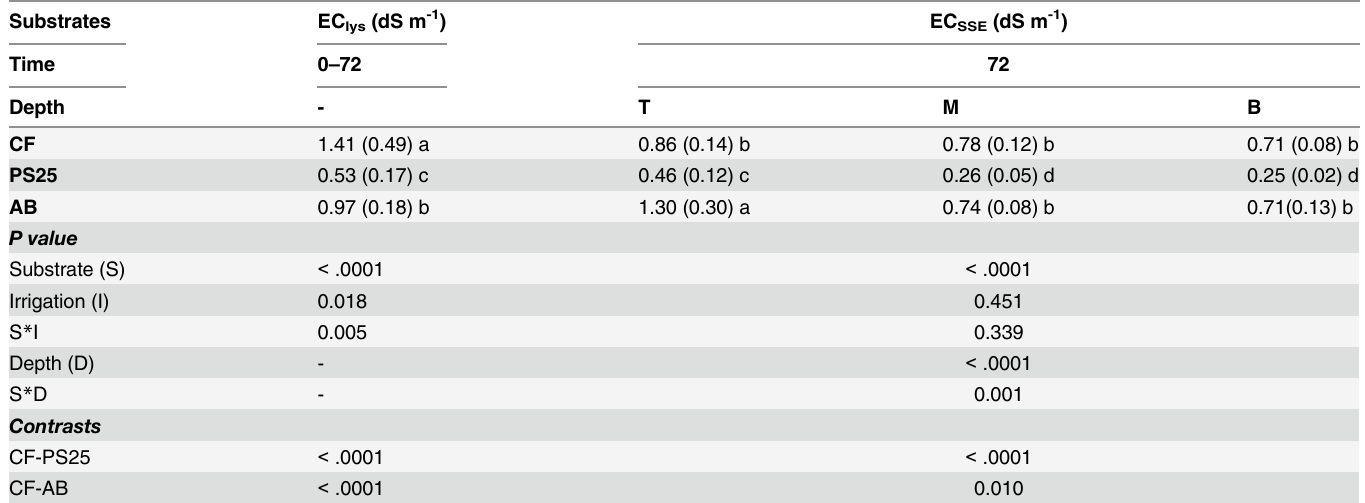
Table 2. Chemical properties of the three substrates. The electrical conductivity was measured on substrate solution extracted using a suction lysimeter (EC lys ) or the SSE method (EC SSE ) at three different substrate depths (T: top; M: medium; B: bottom). No significant effect of time was obtained for EC lys . Dif- ferent letters indicate significant differences at P = 0.05.